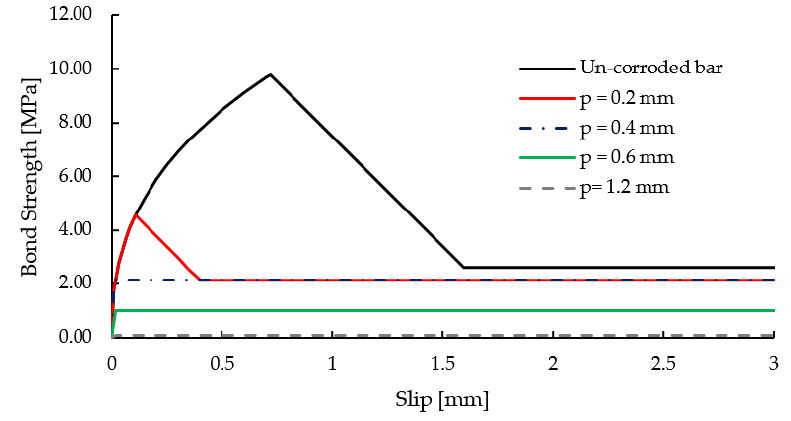
Figure 11. Example of bond law reduction.